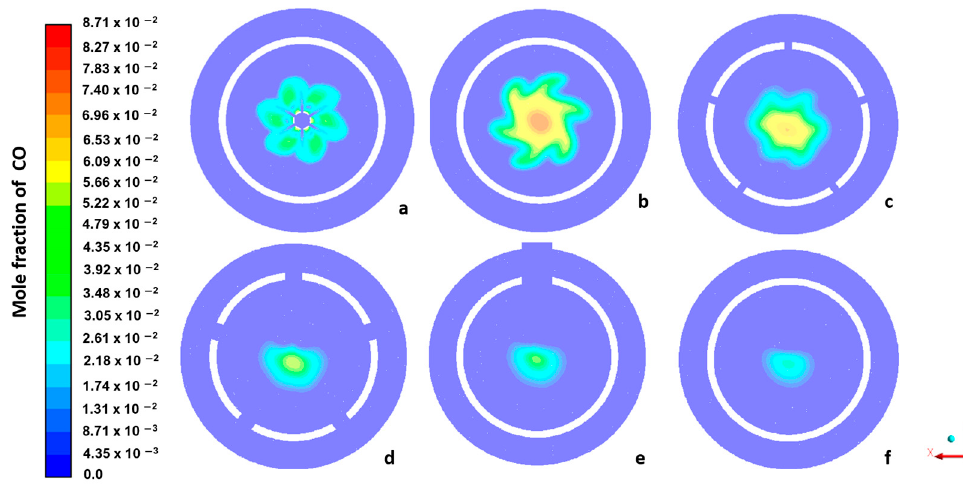
Figure 10. Mole fraction of CO for cross-sectional planes: ( a ) plane 1; ( b ) plane 2; ( c ) plane 3; ( d ) plane 4; ( e ) plane 5; ( f ) plane 6.